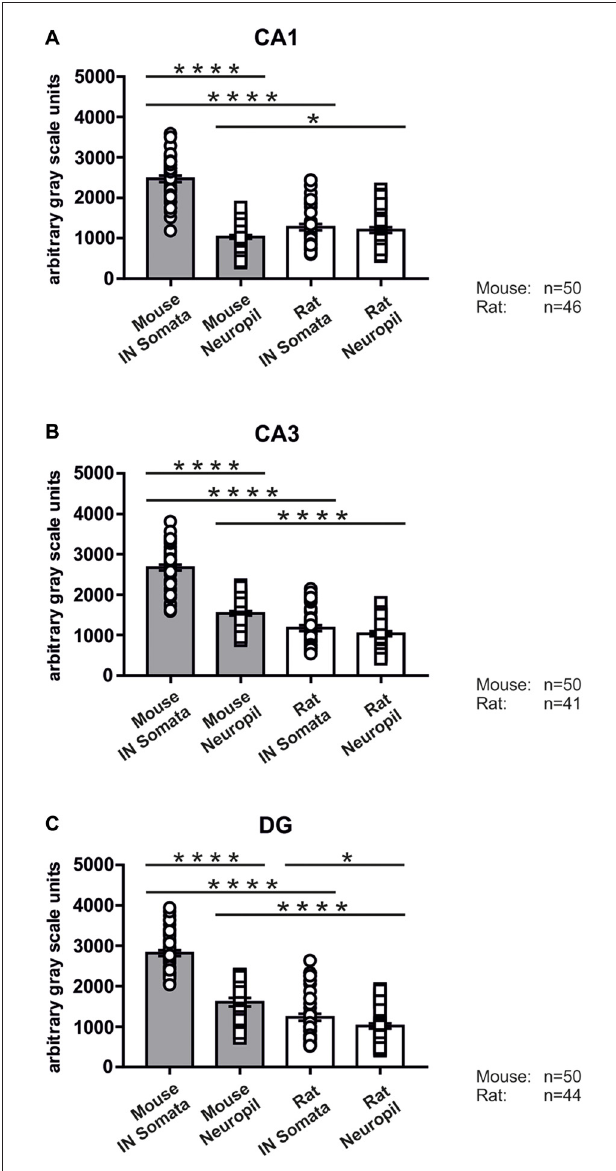
FIGURE 6 | Immunolabeling intensities for SNAP47 in YFP-positive INs and surrounding neuropil in the mouse and the rat hippocampus. Summary bar charts of the immunolabeling intensity for SNAP47 in the somata of YFP-positive INs and surrounding neuropil in the CA1 area (A) , the CA3 area (B) and the DG (C) of the mouse and the rat hippocampus. ∗ P = 0.04, ∗∗∗∗ P < 0.0001.